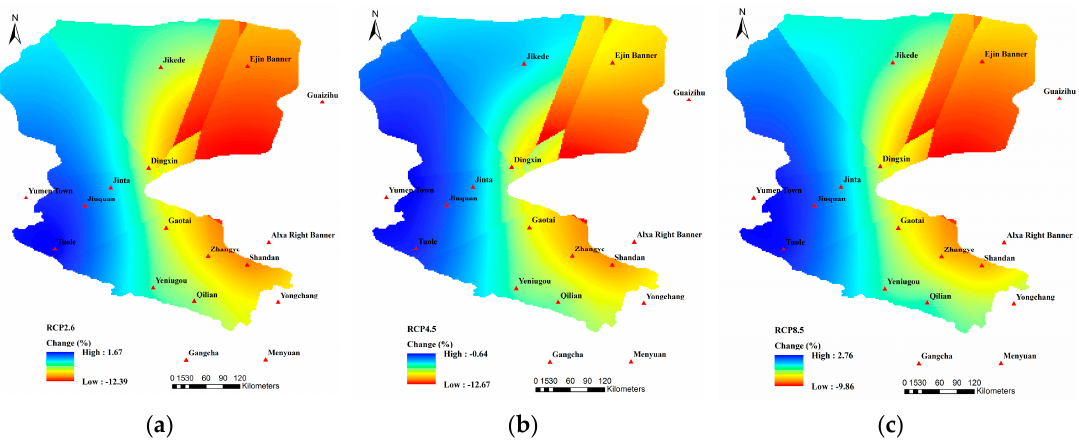
Figure 3. Spatial variation patterns of the mean annual precipitation under ( a ) RCP2.6; ( b ) RCP4.5; and ( c ) RCP8.5. Table 2. Changes of the mean annual precipitation and air temperatures during 2021–2050 under the three RCP scenarios.